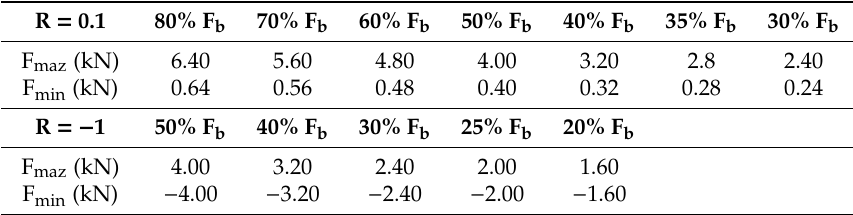
Table 3. Fatigue test parameters of asymmetric fatigue load (R = 0.1) and symmetric fatigue load (R = − 1) of dissimilar Al / steel keyhole-free FSSW